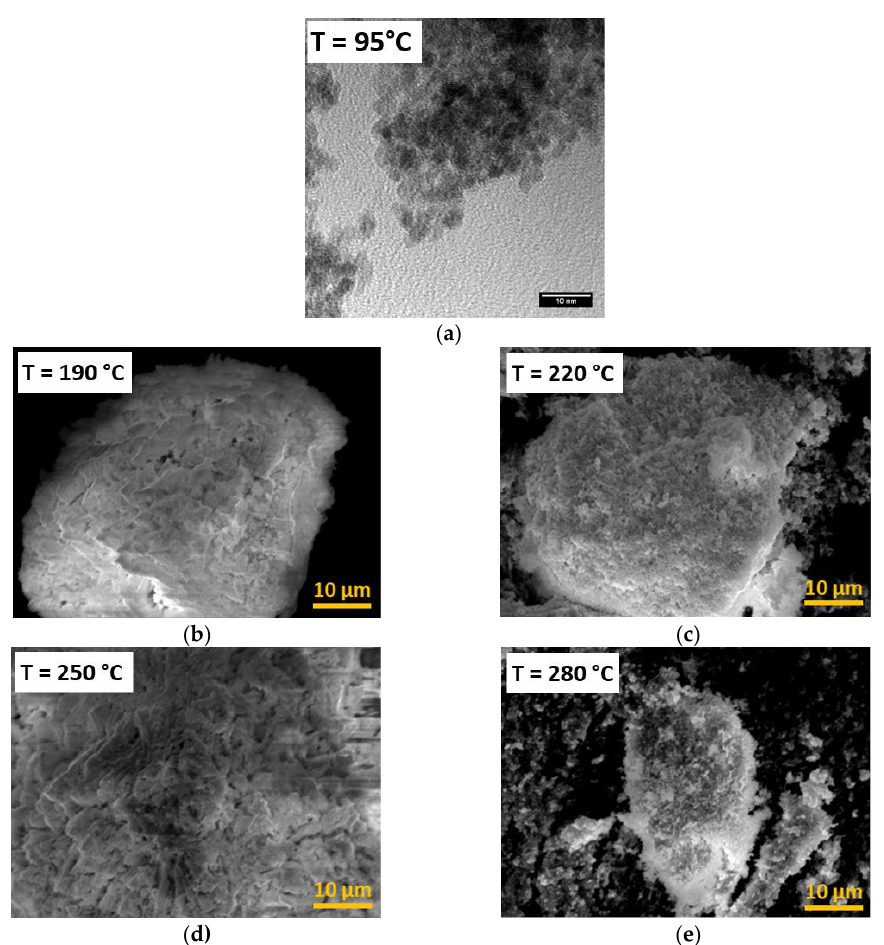
Figure 2. ( a ) Transmission-electron picture of PuO 2 obtained by using the hydrothermal method at 95 °C; ( b – e ) scanning-electron micrographs of PuO 2 nanoparticles prepared by hydrothermal decomposition of Pu(IV) oxalate at different temperatures.